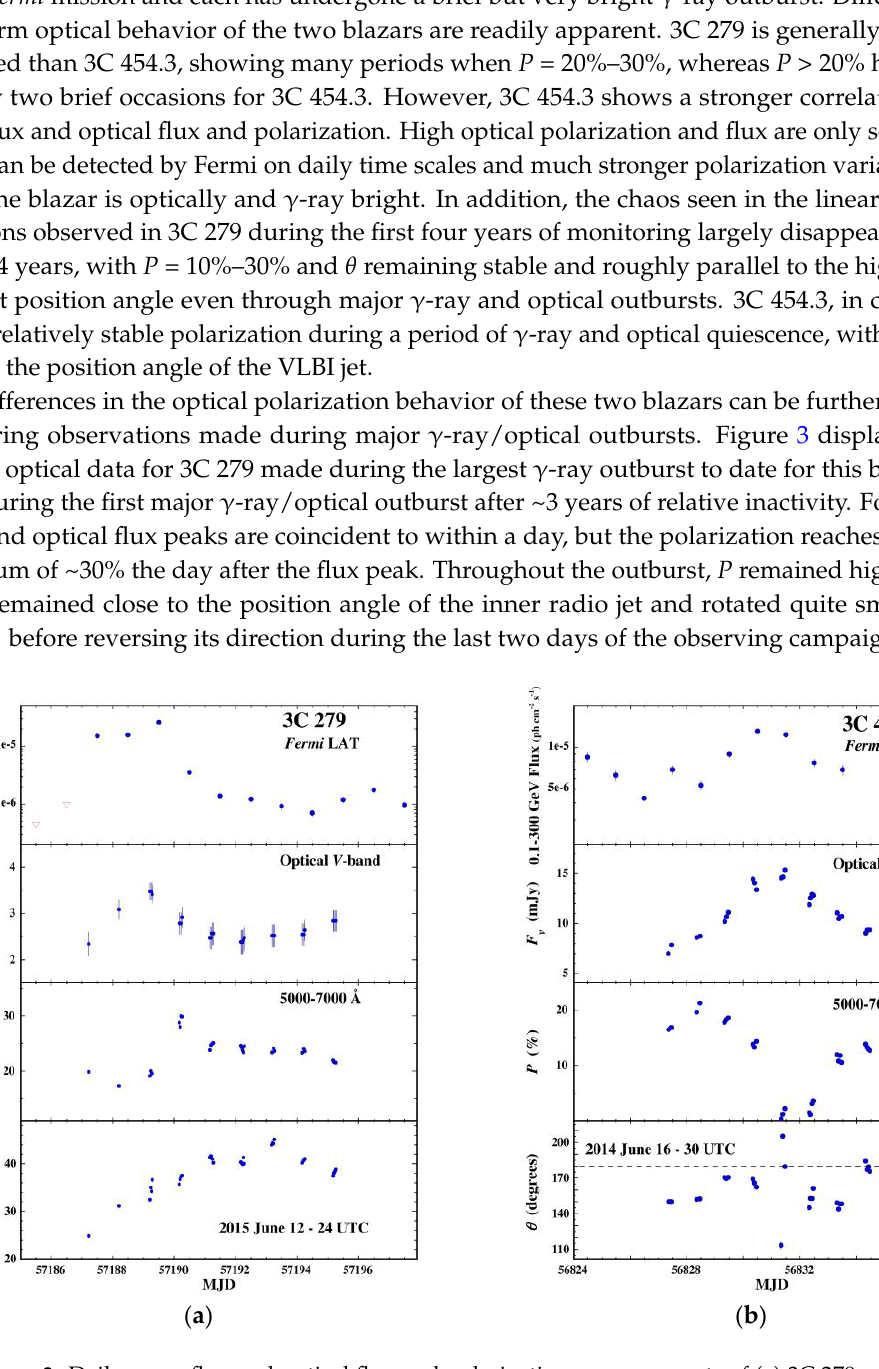
Figure 3. Daily γ-ray flux and optical flux and polarization measurements of ( a ) 3C 279 and ( b ) 3C 454.3 during major outbursts. These plots follow the same format as in Figure 2. Red triangles in the top panel of ( a ) denote upper limits to the γ-ray flux as measured by the LAT. In the bottom panel of ( b ), θ = 0° = 180° is shown by the dashed, horizontal line.